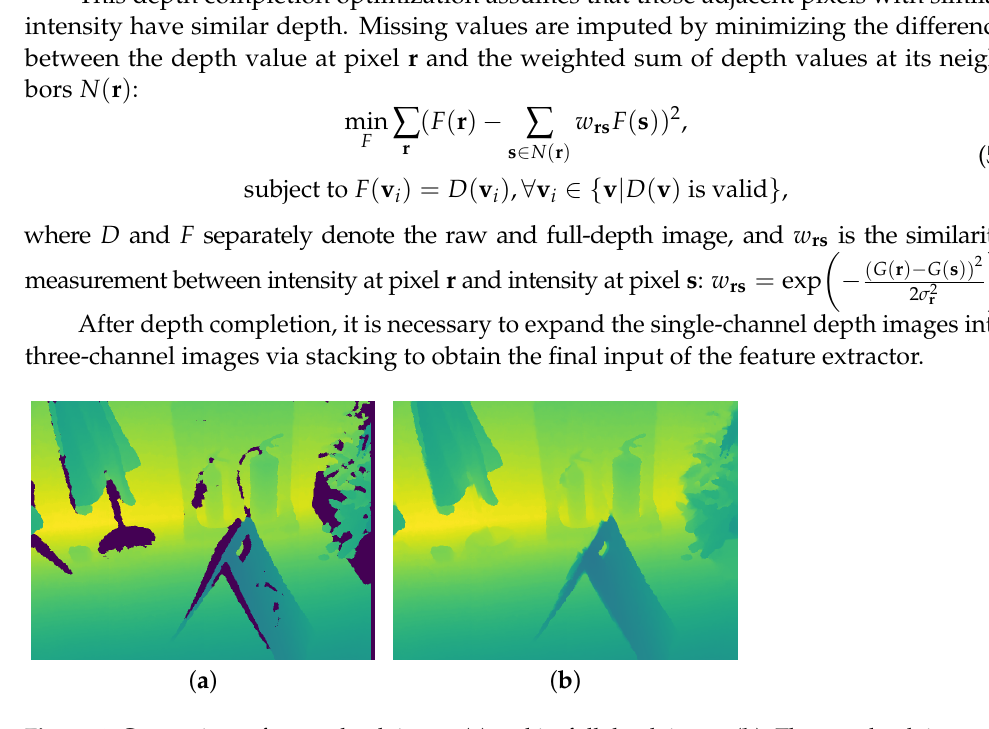
Figure 4. Comparison of a raw depth image ( a ) and its full depth image ( b ). The raw depth image is the first frame of the Fire scene from the 7 Scenes dataset [7], and the full depth image is the result of depth